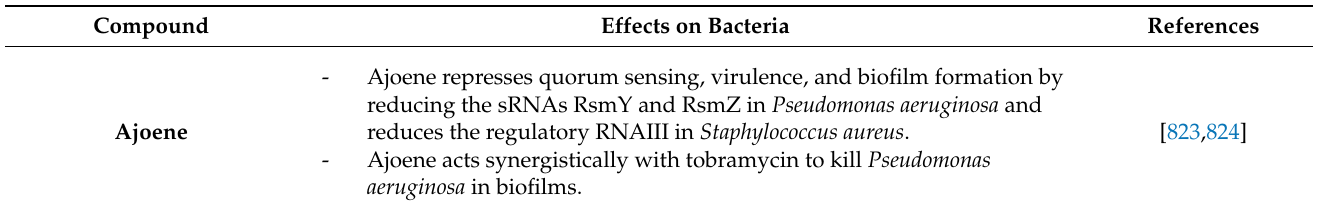
Table 4. Examples of QS inhibitors/QS